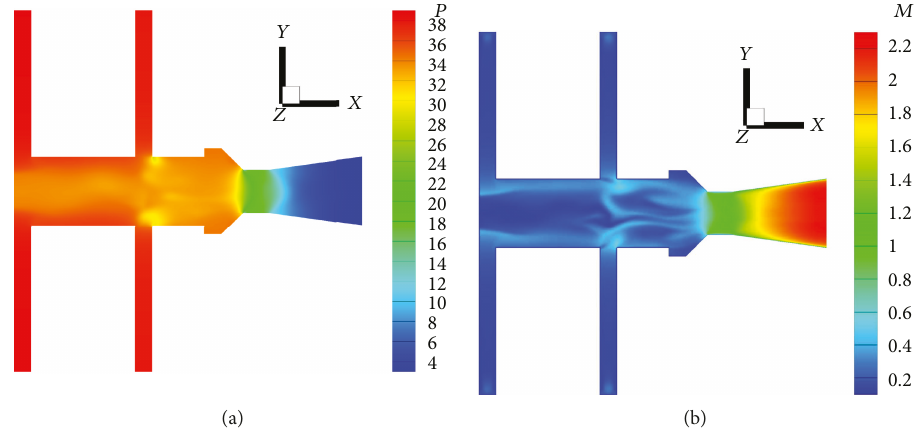
Figure 8: Instantaneous planar distributions on XY section: (a) pressure (atm) and (b) Mach